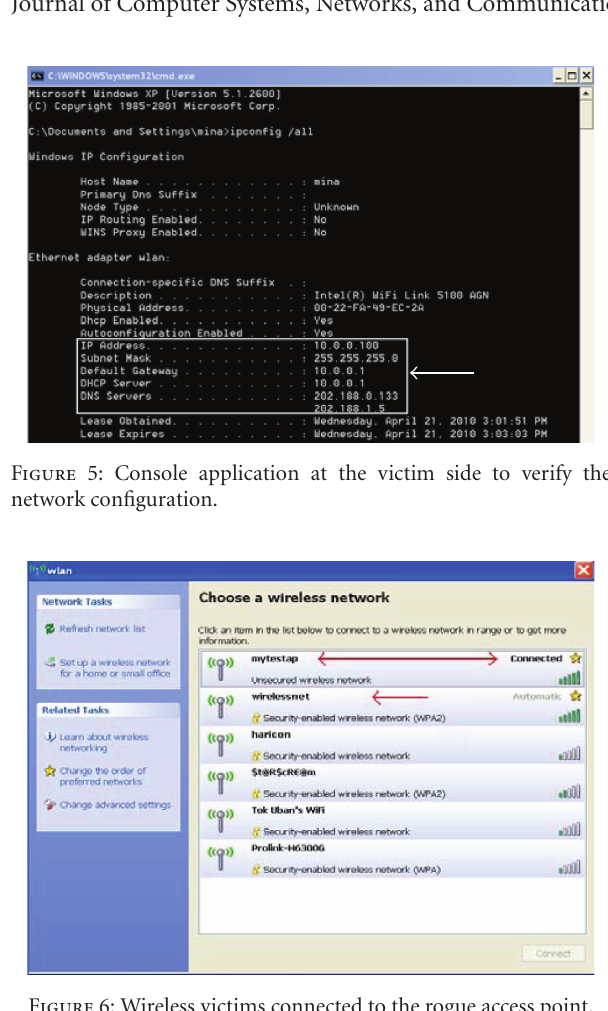
Figure 6: Wireless victims connected to the rogue access point.